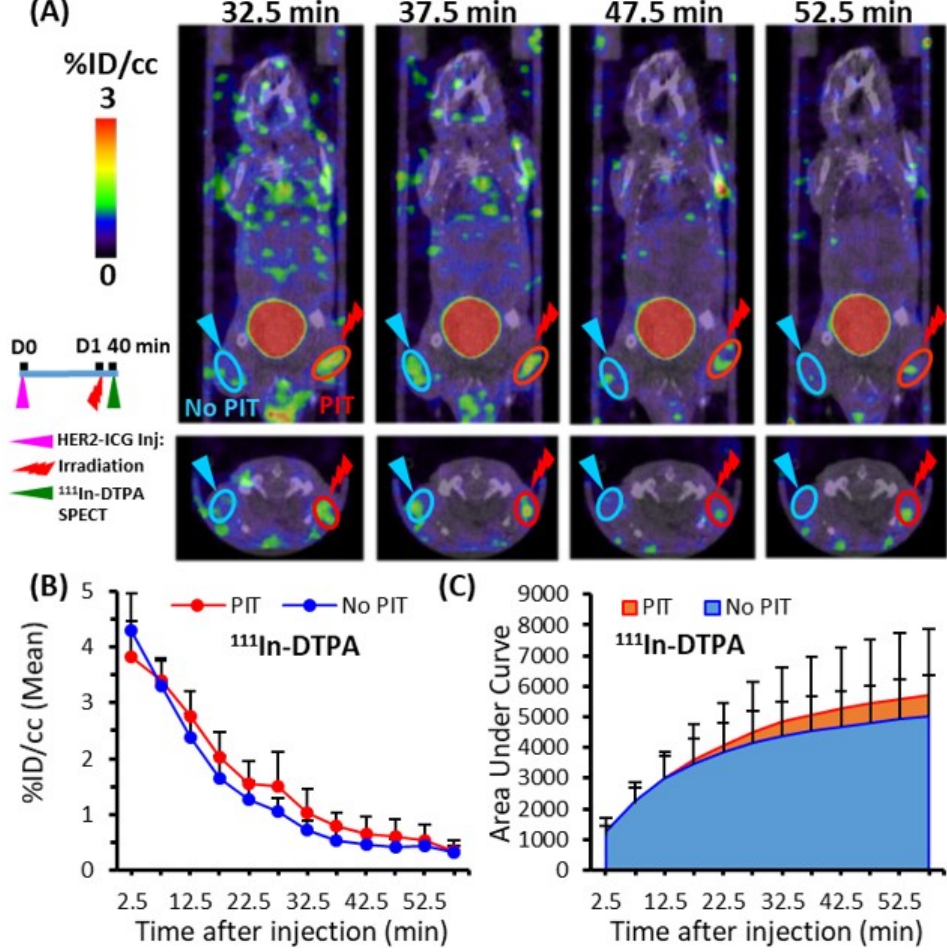
Figure 5. Dynamic SPECT/CT imaging of 111 In-DTPA in tumor-bearing mice. ( A ) Representative SPECT/CT image at four time points (32.7, 37.5, 47.5, and 52.5 min) after PIT. ( B ) Time-activity curve of average accumulation of 111 In-DTPA. ( C ) Summed values of the areas under the curve (AUCs) for each time point were evaluated. Uptake in the PIT-treated tumors (red) was compared with untreated tumors (blue). Data are presented as means ± SD ( n =